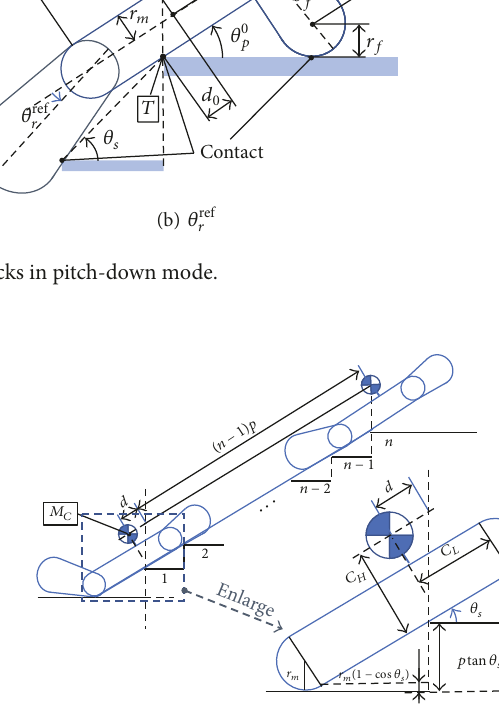
Figure 11: Distance to move in the normal climbing